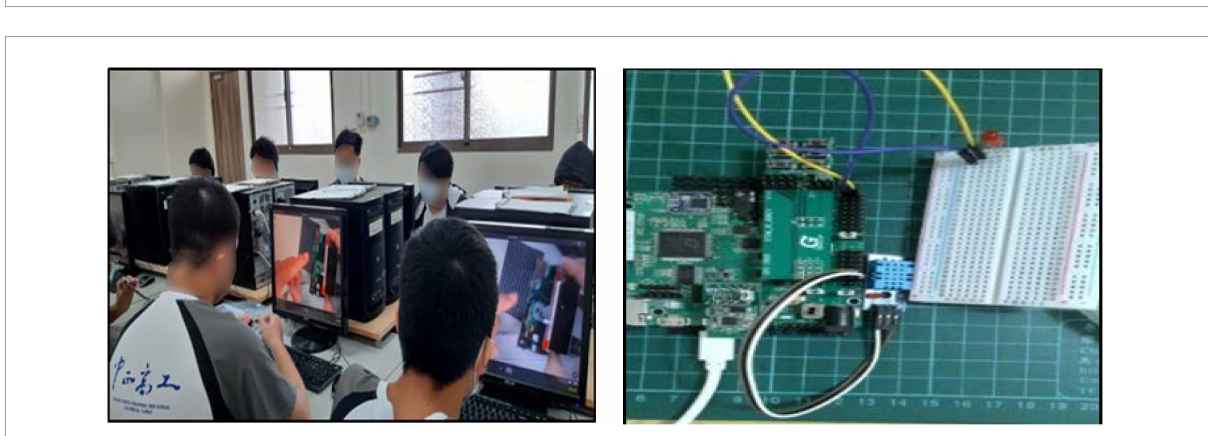
FIGURE3 The practical operation of Genio Demo